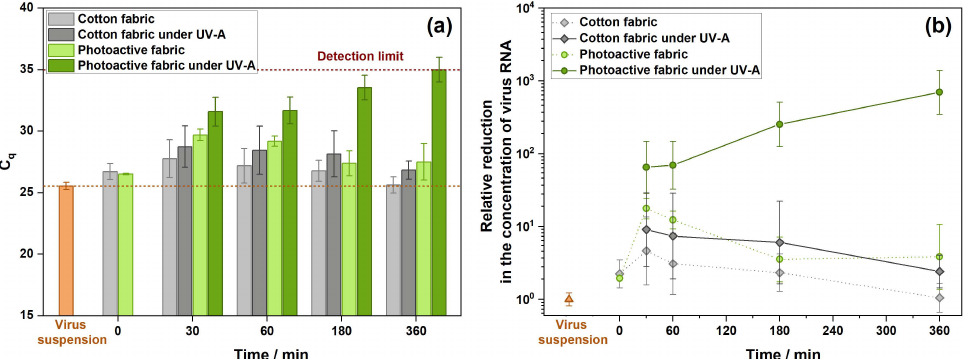
Figure 4. PCR data on threshold cycle values Cq ( a ) and normalized concentration of virus RNA ( b ) for initial virus suspension and washouts from the textile